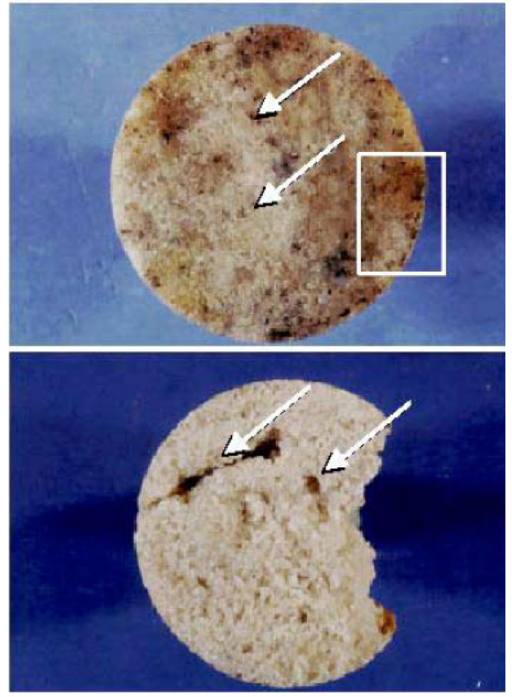
Fig. 6 Wormholes in South American sandstone by Kalfayan and Metcalf